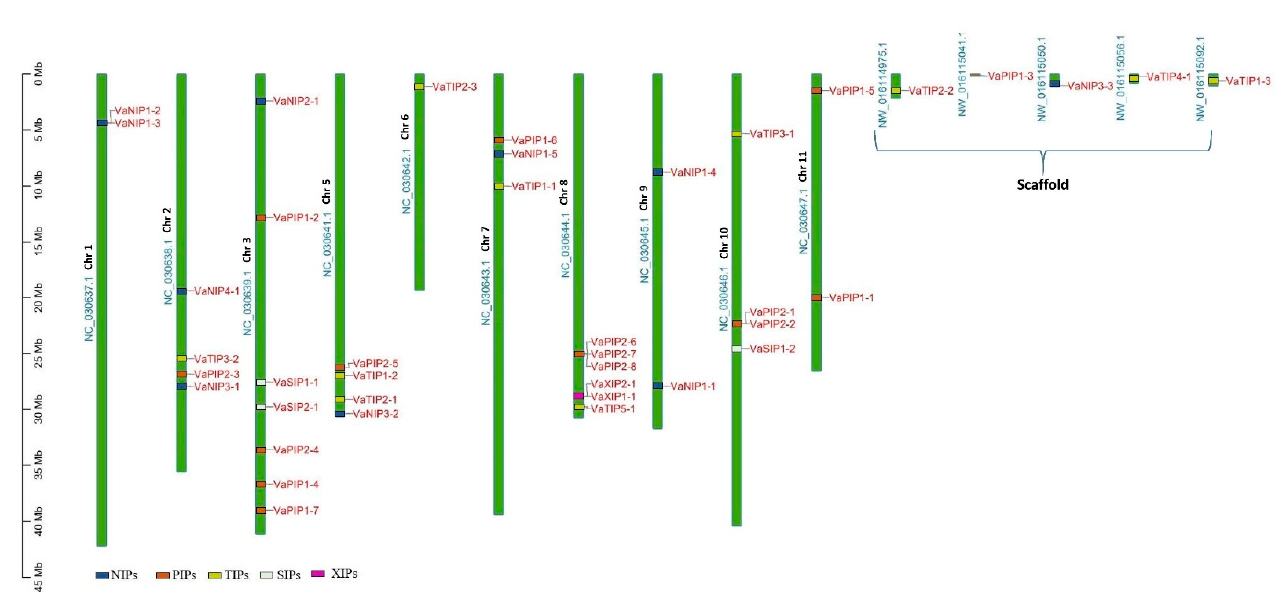
Figure 1. Genome-wide distribution of AQPs genes on the chromosomes of Vigna angularis. The right side of the chromosomal bar indicates the names of VaAQP genes, and the position is mentioned in megabase pairs (Mb) given on the left side. The “VaNIP” genes are represented in blue, “VaPIP” genes are in orange, “VaTIP” genes are in yellow, “VaSIP” genes are in white and “VaXIP” genes are in pink color.